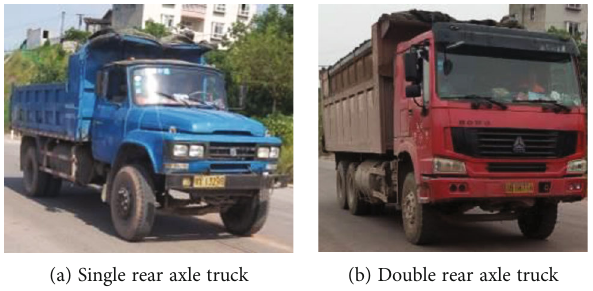
Figure 3: Asphalt pavement dynamic response test.